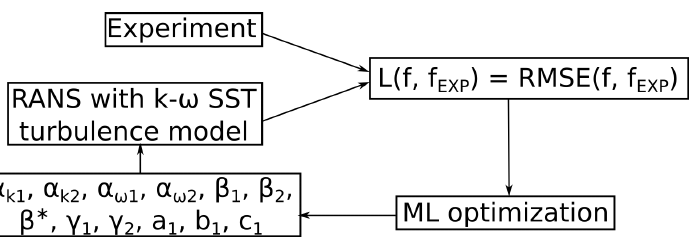
Figure 6. The architecture of the proposed algorithm for calibrating the k - ω SST turbulence model